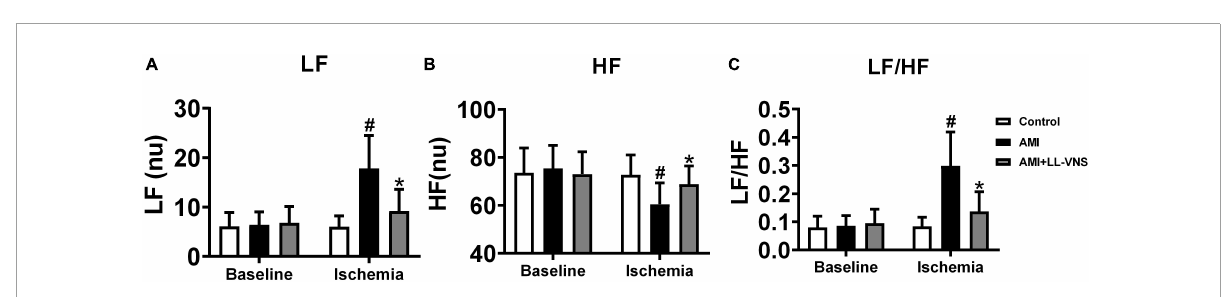
FIGURE4 Effects of LL-VNS on cardiac autonomic nervous activity. Panels illustrate changes among the three groups between baseline and measurements taken 30 min after AMI in LF (A) , HF (B) , and LF/HF (C) . AMI induced an increase in LF and LF/HF, but a reduction in HF, as indicated by comparison between the AMI and Control groups. In comparison with the AMI group, LF and LF/HF were significantly reduced in the LL-VNS group, but HF was increased. AMI, acute myocardial infarction; HF, high frequency; LF, low frequency; LF/HF, low frequency to high